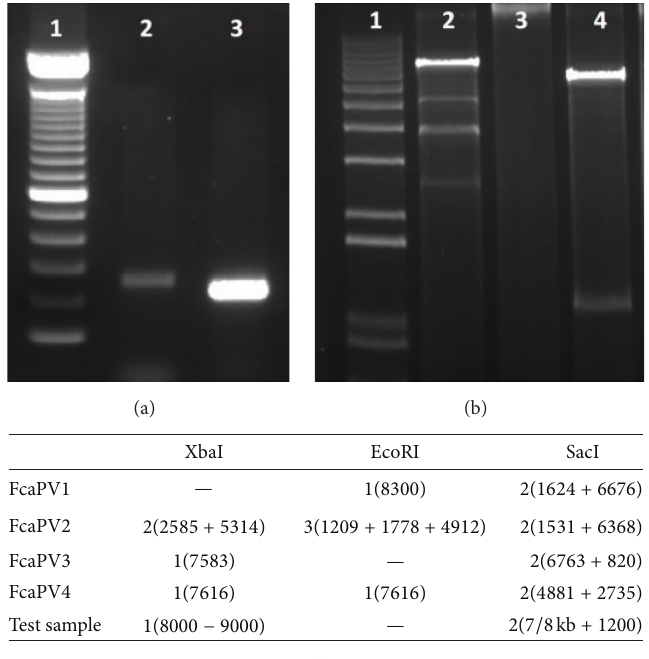
Figure 2: Molecular detection and typing of feline papillomavirus. In (a) PCR results demonstrating the presence of at least two PV types are shown (1, Life Technologies 100 bp DNA Ladder; 2, 3, positivity to primers FPV12F/R and FPV34F/R, resp.). Results obtained with rolling circle amplification (RCA) (b) and restriction enzyme digestions of the RCA products (c) indicating the presence of FcaPV3 in the lesion.